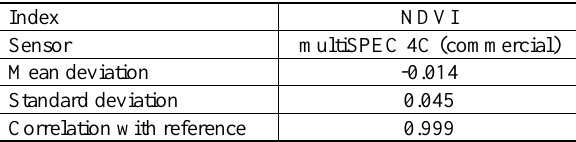
Table 4. Comparison of the multiSPEC sensor with field spectrometer measurements based on derived NDVI values.